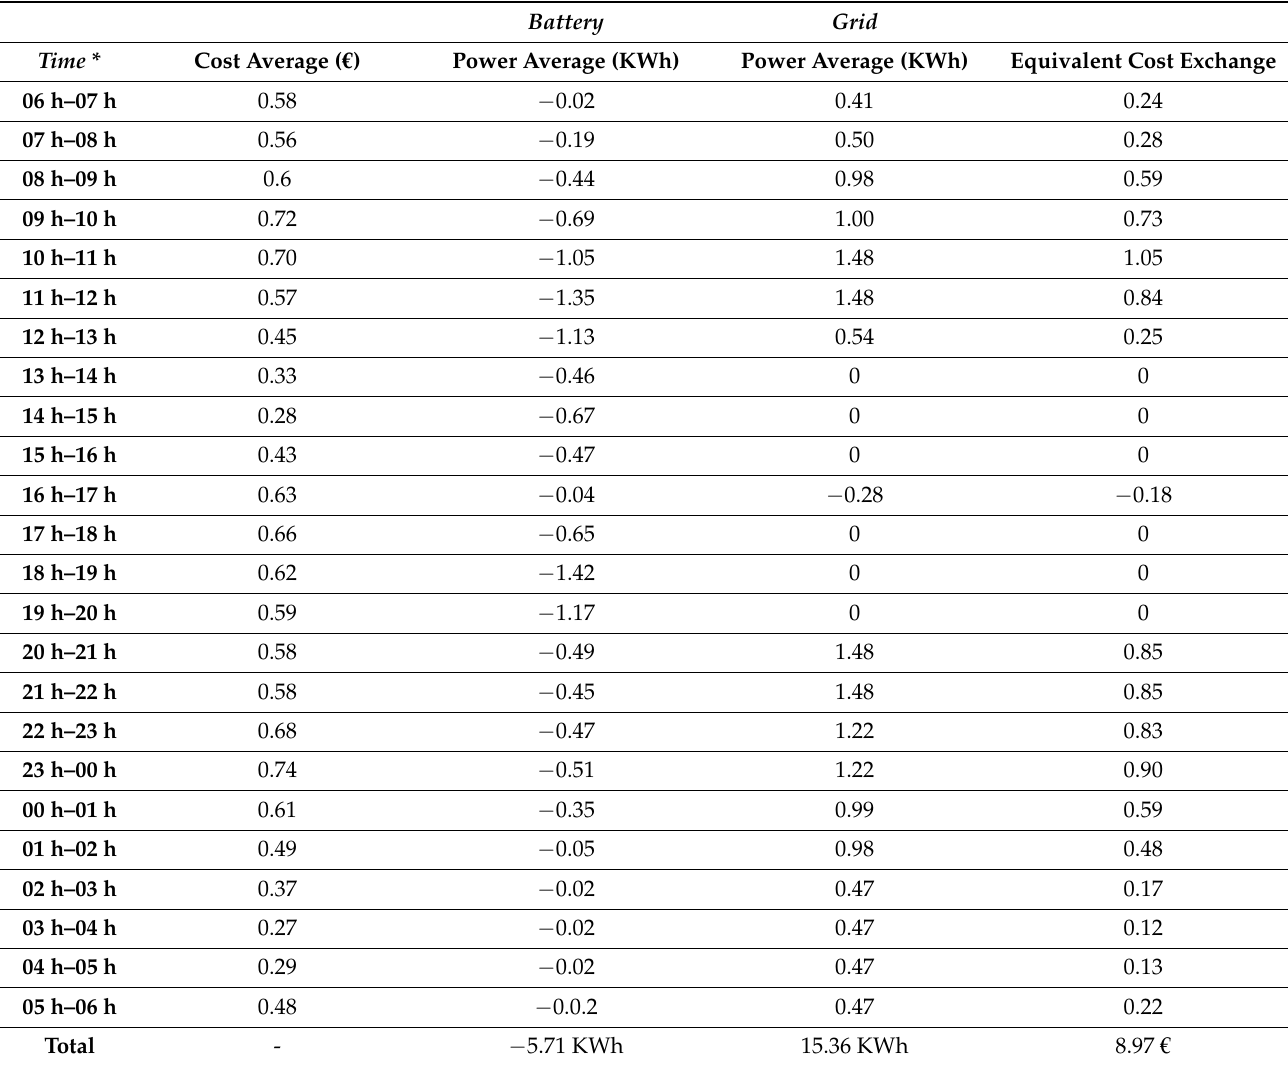
Table 3. Electricity price benefit for Case